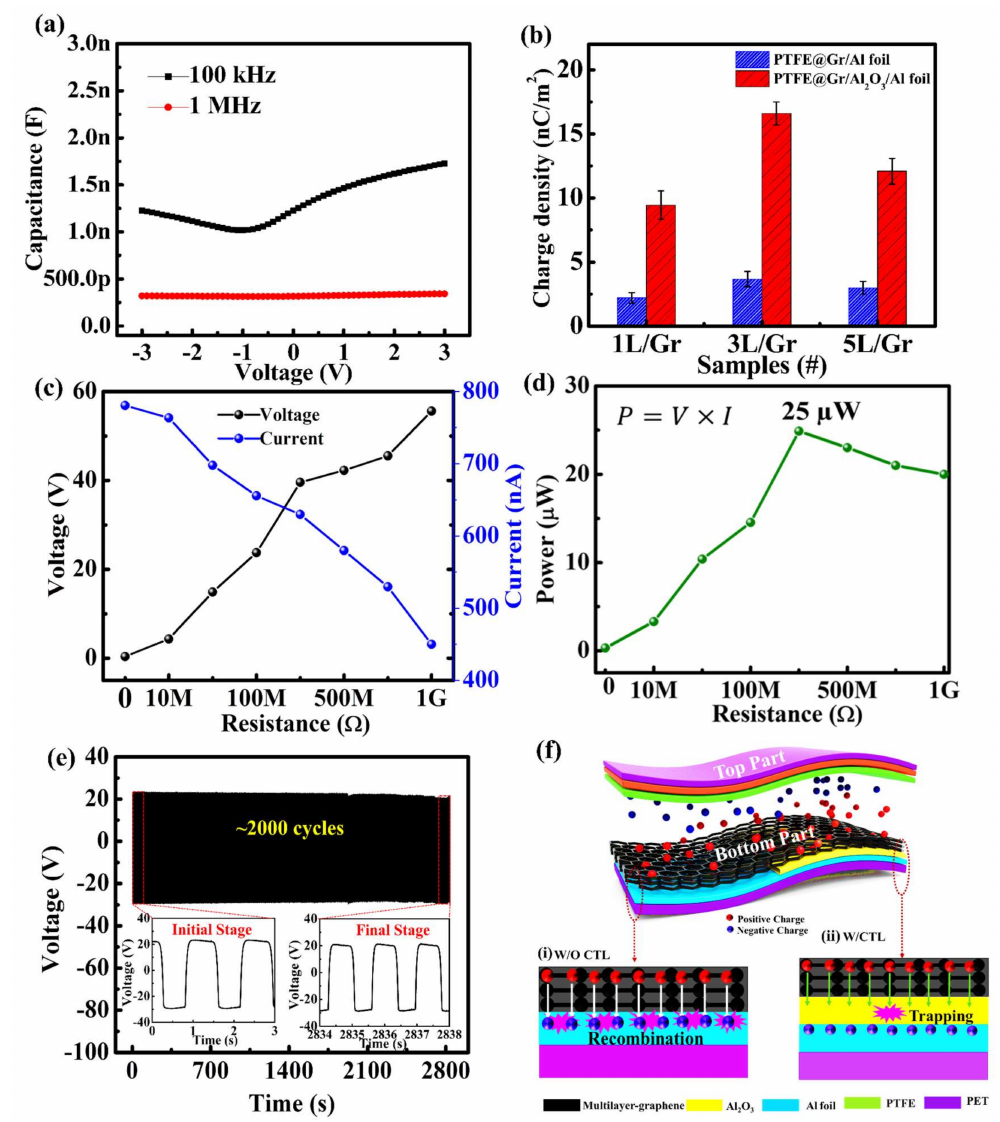
Figure 7. Performances of the 3L-Gr-TENG with the CTL: ( a ) CV characteristics of Al/Al 2 O 3 /3L- Gr/Al at frequencies of 100 kHz and 1 MHz. ( b ) Surface charge density of graphene (1L, 3L and 5L)-based TENG with and without Al 2 O 3 as CTL. ( c ) Dependence of the output voltage and current outputs as a function of different resistors as external loads. ( d ) Relationship between electrical output power and external loading resistance. ( e ) Mechanical stability and durability test of the TENG with the continuous application of ~2000 cycles. The inset shows the output voltage at the initial stage and the final stage after ~2000 cycles. ( f ) Schematic illustrations showing the charge-trapping mechanism of 3L-Gr-TENG without and with Al 2 O 3 charge trapping